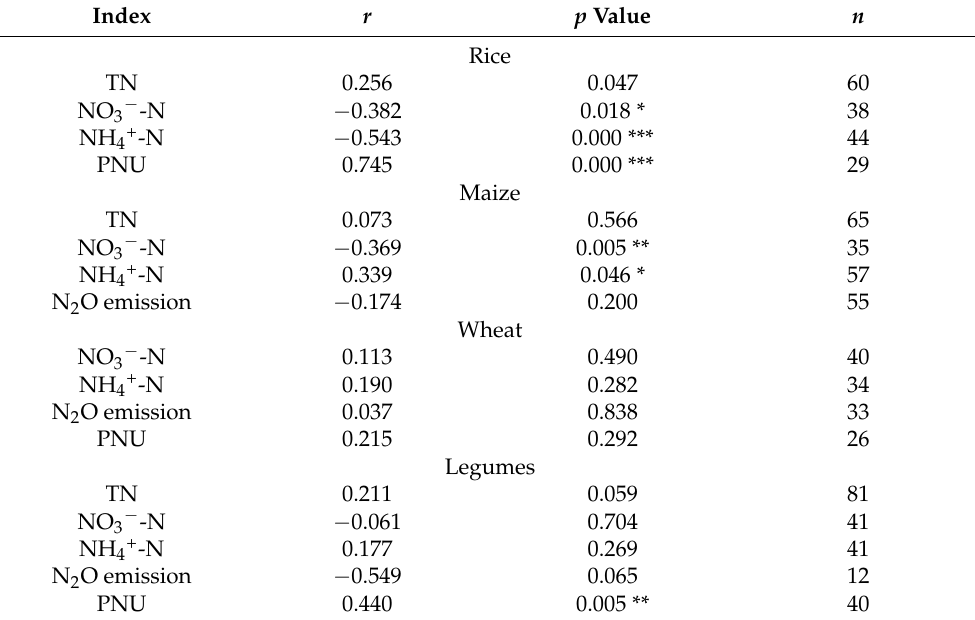
Figure 2. Relationships between the response ratios of wheat, rice, maize, and legume productivity vs. the response ratios of ( a ) soil total N, ( b ) N 2 O emission, ( c ) plant N uptake, and ( d ) biological N 2 fixation. Table 1. Pearson correlation coefficients ( r ) between the response ratios (Equation (1)) of different crops’ productivity and soil nitrogen (N) cycle parameters. Sample size is depicted by n .